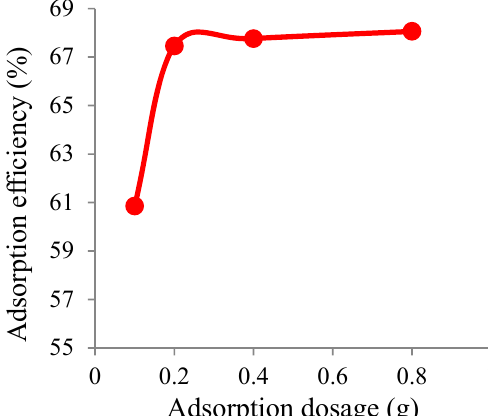
Fig. 6: Effect of pH on the adsorption efficiency of cadmium.